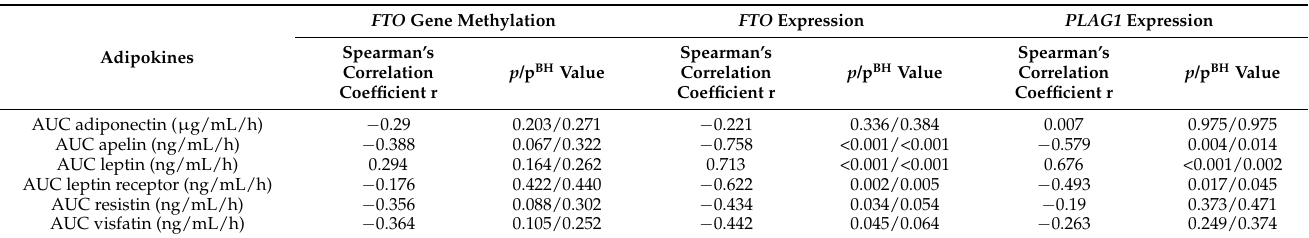
Table 4. Correlation results of the adipokines serum levels with the FTO gene methylation, expression and PLAG1 gene